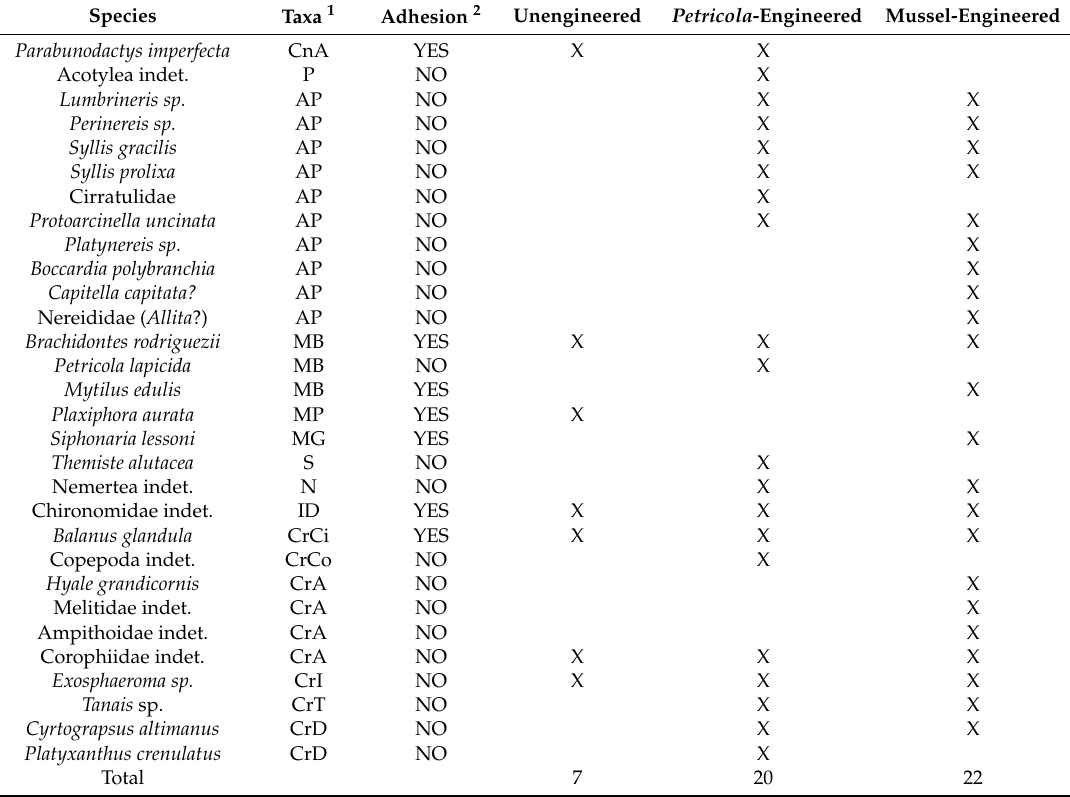
Table 1. Species found at the lower platform in unengineered and Petricola -engineered patches and at the upper platform in mussel-engineered patches (i.e., mussel beds). Species Taxa 1 Adhesion 2 Unengineered Petricola -Engineered Mussel-Engineered Parabunodactys